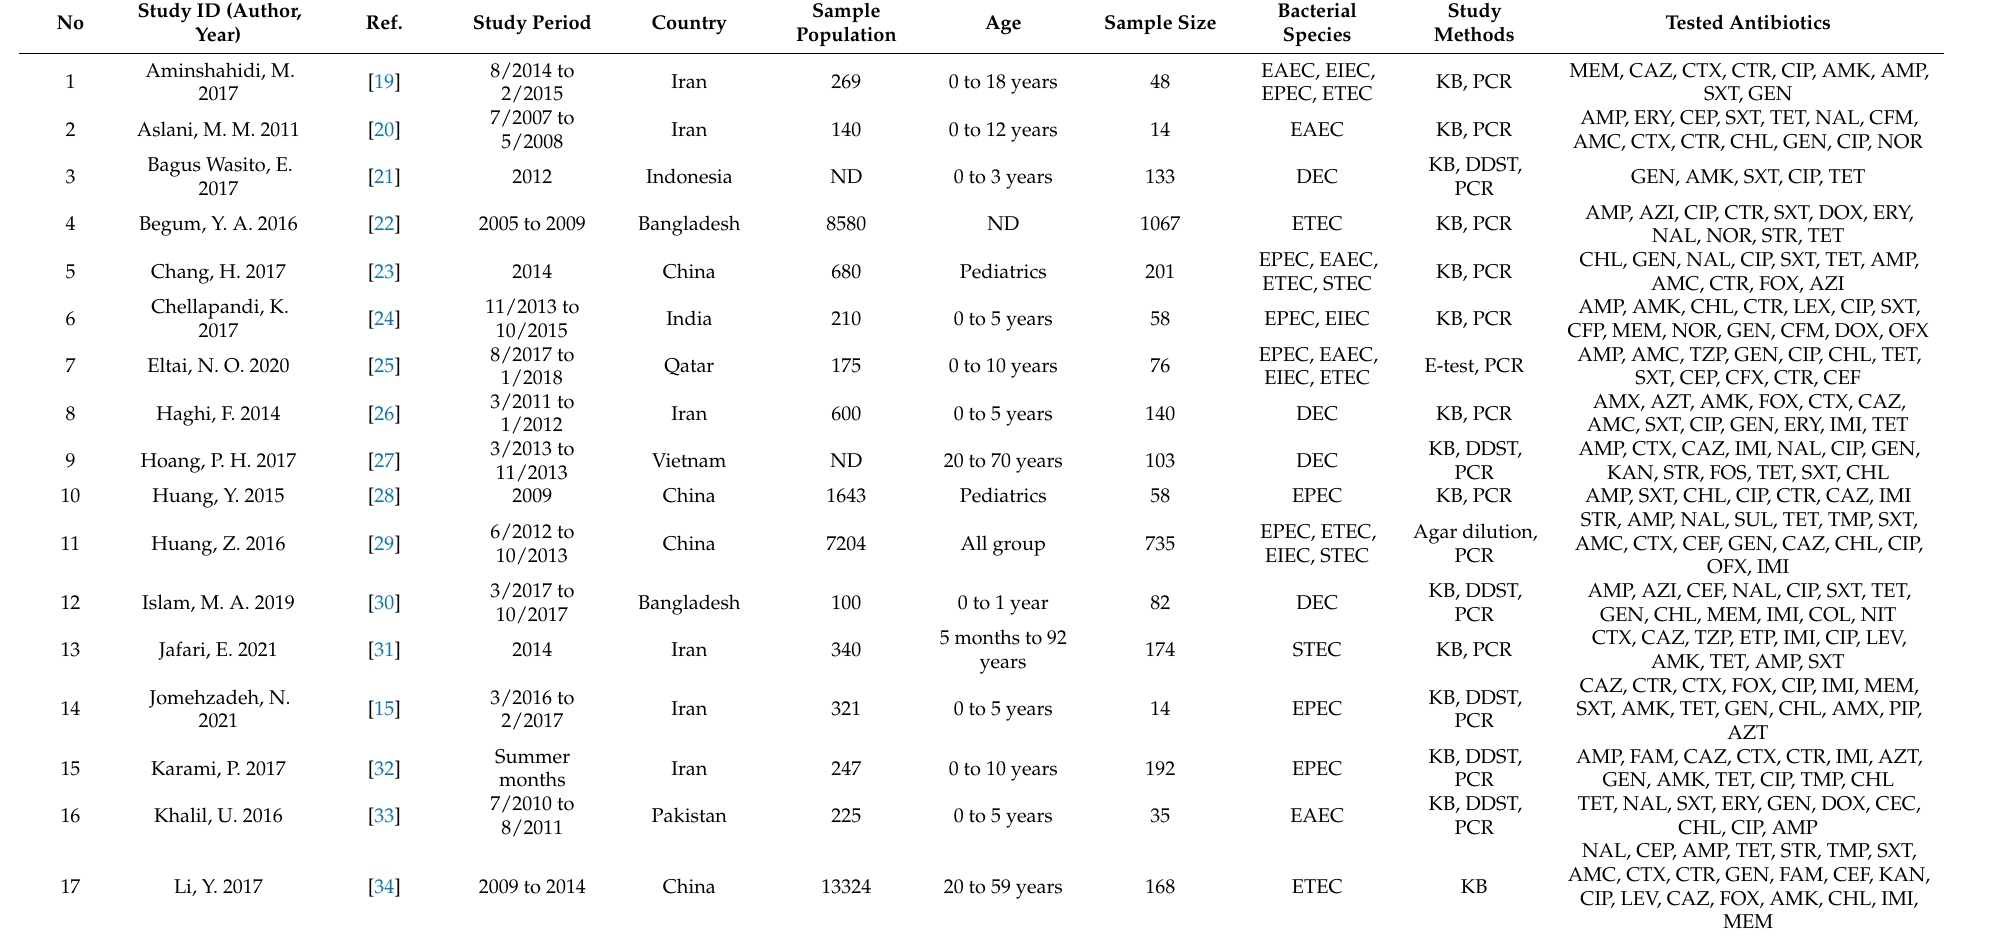
Table 1. Major characteristics of the 40 included studies in this systematic review and meta-analysis